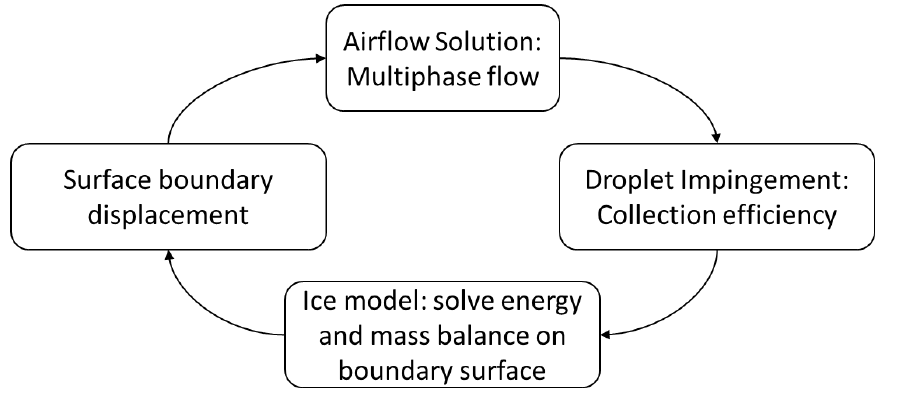
Figure 1. Diagram of ice accretion model based on CFD.